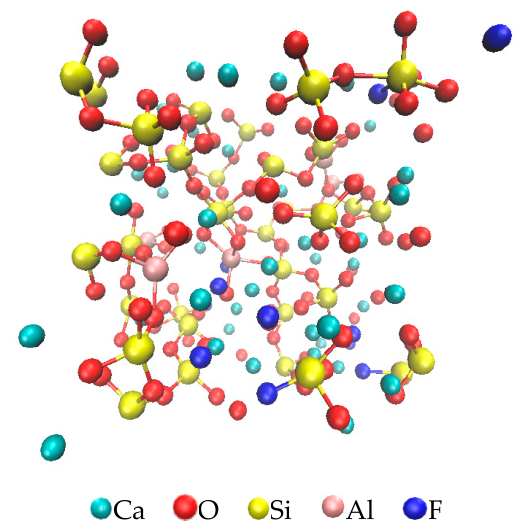
Figure 6. Model of ions in the mold flux with 9% CaF 2 , obtained through simulation in Scigress.